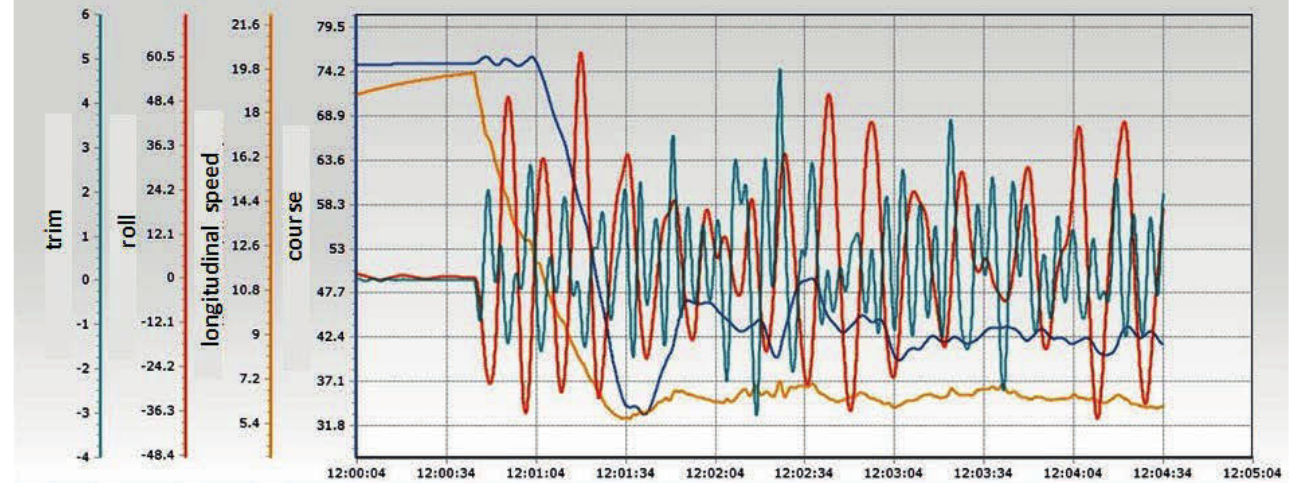
Fig. 7. Automatic control of the vessel Ro-Ro passenger ferry 13 in a